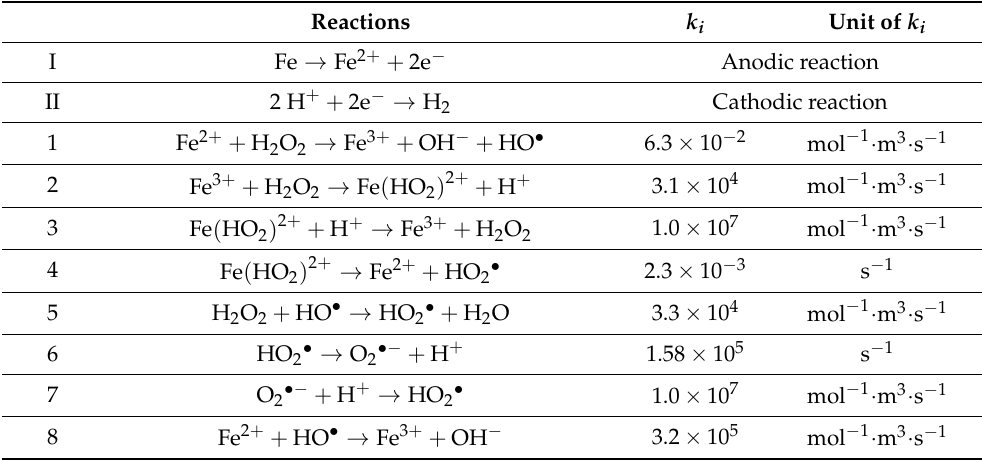
Table 1. Chemical schema of elementary reactions occurring in Galvano-Fenton process